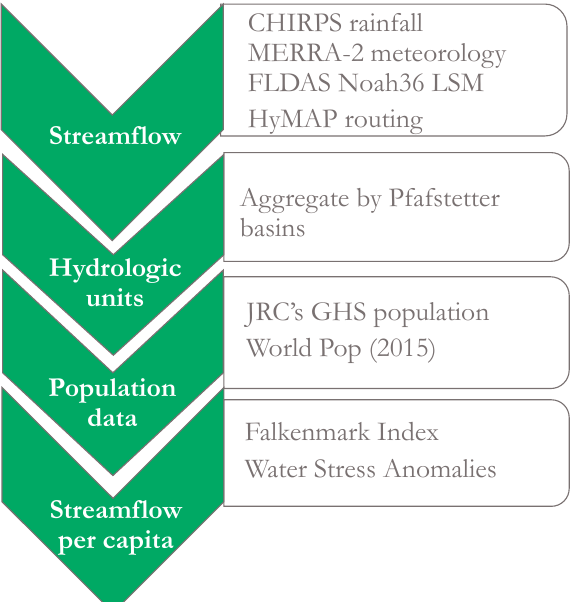
Figure 1. Our approach for water scarcity monitoring for Africa, with the Climate Hazards Group InfraRed Precipitation with Stations (CHIRPS) rainfall and Modern-Era Retrospective analysis for Research and Applications (MERRA-2) meteorological estimates used as input to the Famine Early Warning System Network Land Data Assimilation System (FLDAS) Noah 3.6 + Hydrologic Modeling and Analysis Platform (HyMap) routing scheme. Streamflow and population estimates are aggregated by Pfafstetter basins before computing Falkenmark water-scarcity categories, and water-scarcity anomalies. Routinely updated at https://lis.gsfc.nasa.gov/projects/fewsnet.